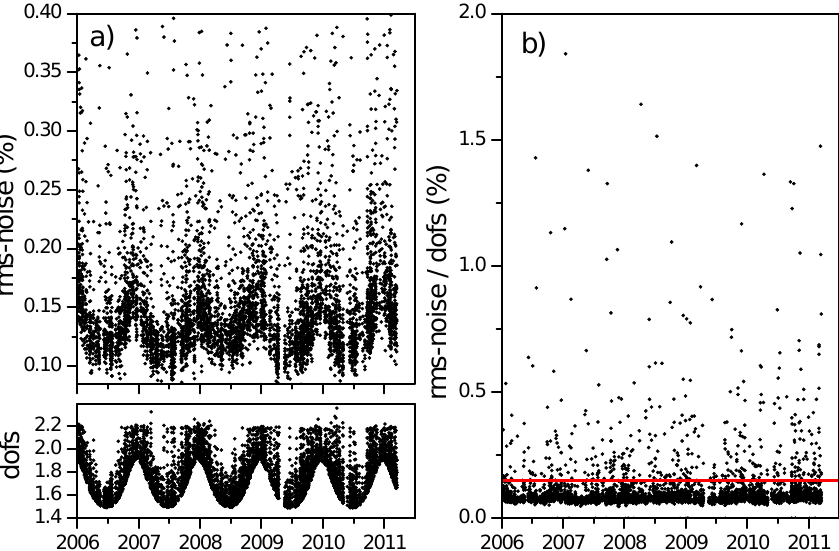
Fig. 5. (a) Upper trace: time series of spectral rms-noise calculated from the out-of-band 2615.25–2615.40cm − 1 wave number interval for the Zugspitze site; lower trace: resulting degrees of freedom for signal (dofs) from fitting micro windows 1, 3, and 5 using HITRAN 2000. (b) Ratio of spectral residuals and dofs. Red line: quality selection